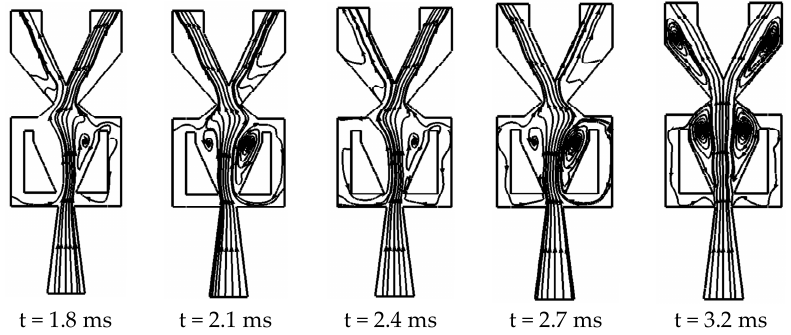
ff erent times in model M 7,